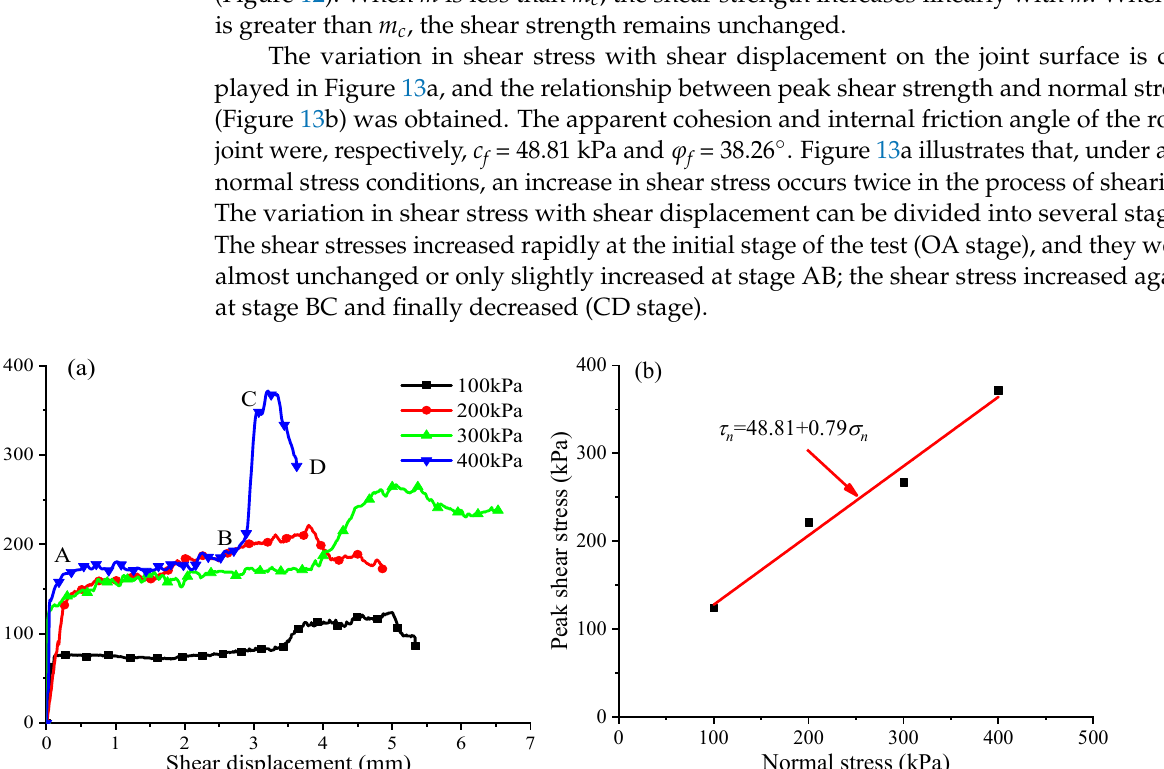
Figure 12. Failure modes of rock joints during direct shear test. ( a ) Joint matching; ( b ) Dilatancy failure; ( c ) Fracture failure. The aspect ratio of the local convex area is m = h / l , and the dilatancy is δ .